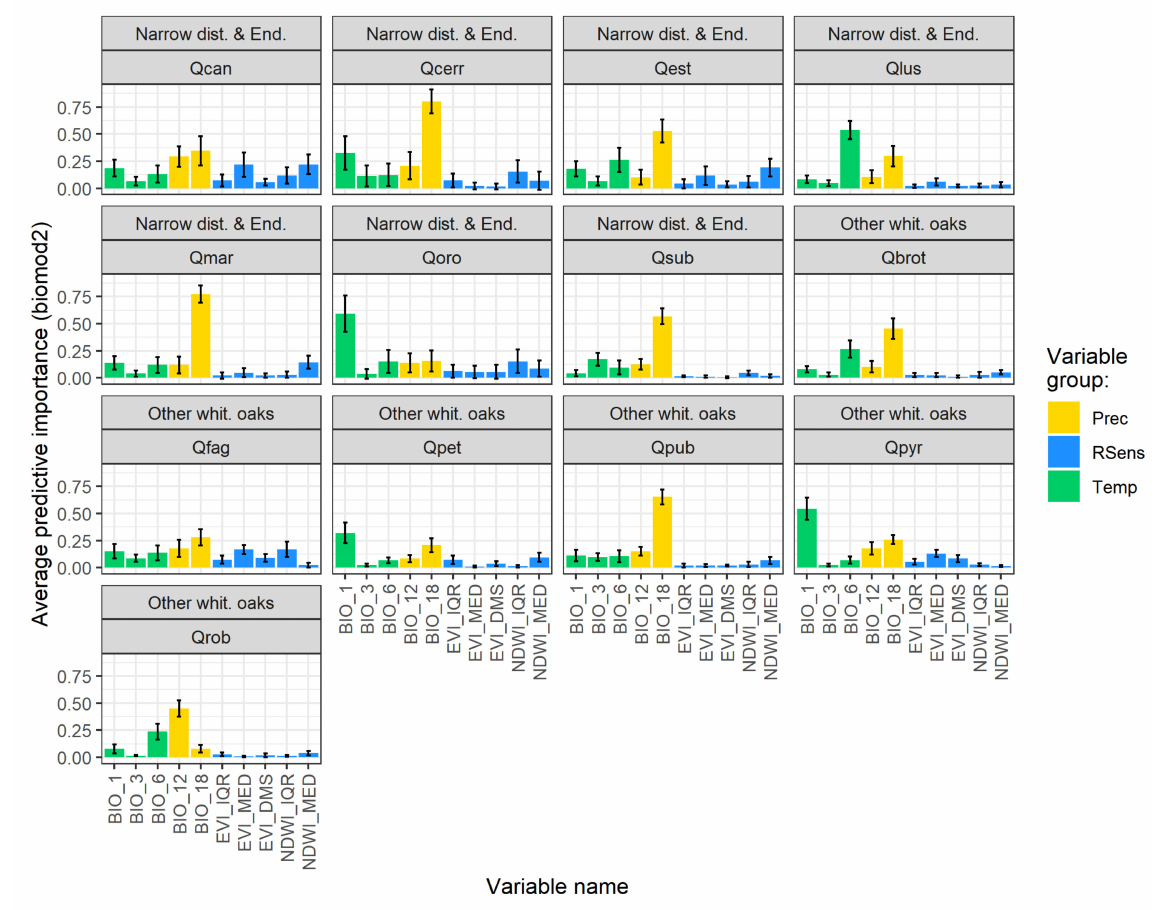
Figure 4. Variable importance (average ± standard deviation across all models) for each oak species considering the two groups of predictors, climatic (precipitation and temperature) and satellite-based EFAs. BIO_1—annual mean temperature; BIO_4—temperature seasonality; BIO_6—min temperature of coldest month; BIO_12—annual precipitation; BIO_18—precipitation of warmest quarter; EVI_IQR—seasonality (EVI intra-annual variation); EVI_MED—productivity (EVI median); EVI_DMS—phenology (EVI day of maximum—spring). Precipitation-related variables (“Prec”, shown in yellow), temperature (“Temp” in green) and remotely-sensed EFA’s (“RSens”, in